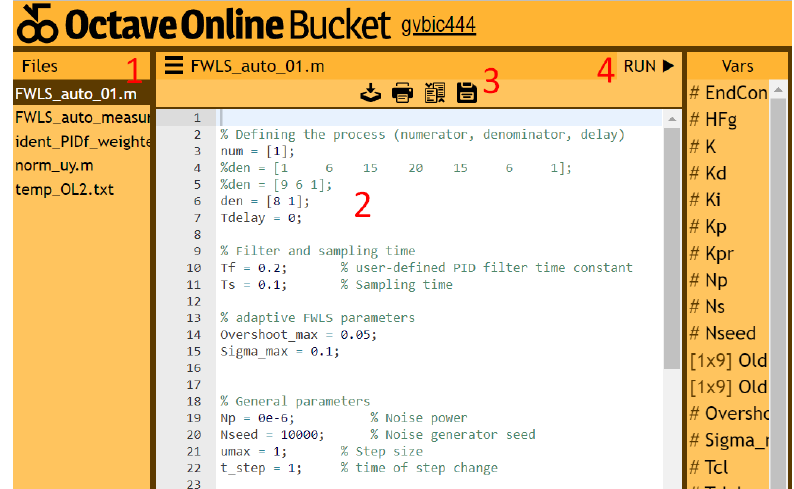
Figure 16. The Octave Bucket screen which runs the script for the calculation of the controller parameters.